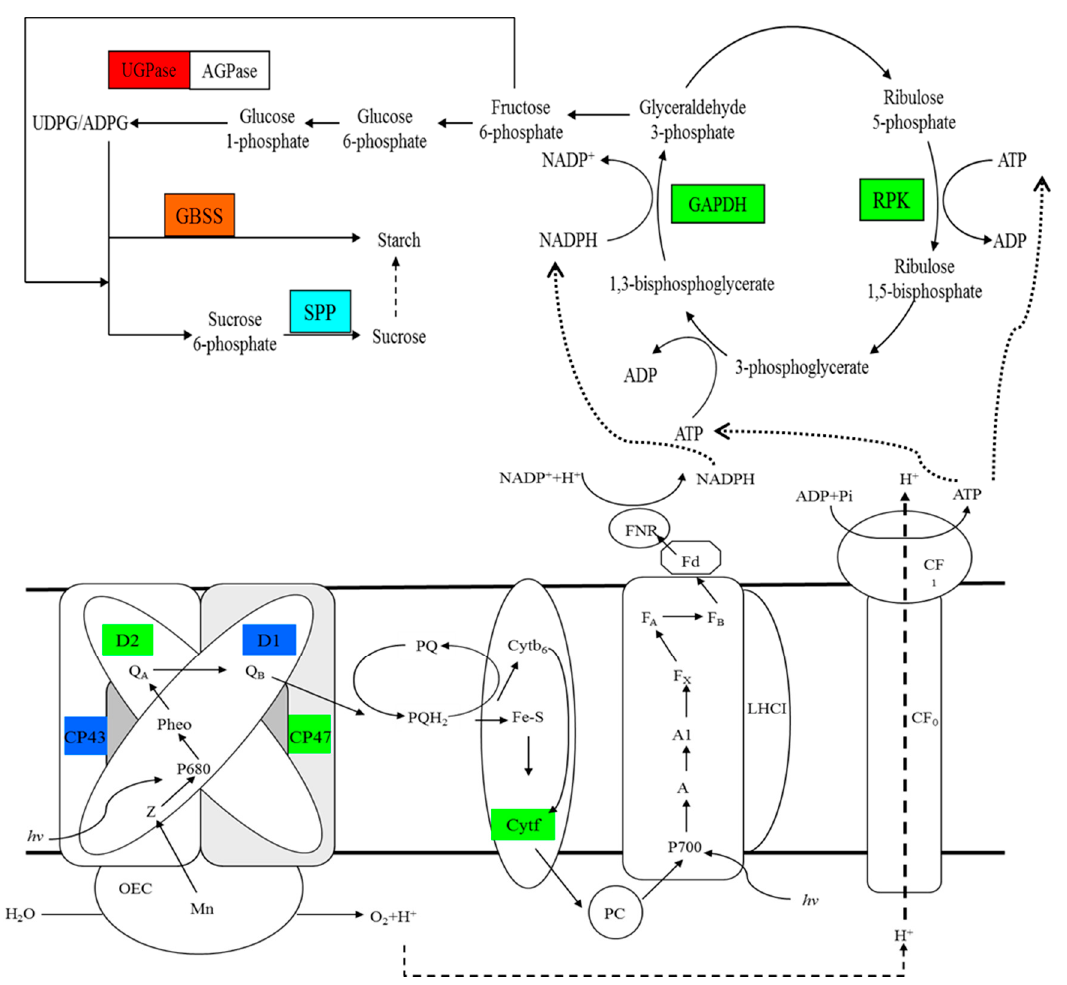
Figure 8. Changes in the photosynthetic electron transfer chain, Calvin cycle, and biosynthesis pathway of sucrose and starch in response to rapid changes in temperature in M. baccata leaves. The red box represents a protein only upregulated at 20 °C as compared to that at 5 °C. Green boxes indicate proteins only downregulated at 0 °C as compared to that at 5 °C. Oxford blue boxes indicate proteins downregulated at both 20 and 0 °C as compared to that at 5 °C. The light blue box indicates a protein only downregulated under calcium treatment at 0 °C. The orange box represents a protein upregulated at both 20 °C as compared to that at 5 °C, and under calcium treatment at 0 °C. AGPase, ADP-glucose pyrophosphorylase; Cytb6, cytochrome b6; Cytf, cytochrome f; FNR, ferrdoxin-NDAP + reductase; GAPDH, glyceraldehyde-3-phosphate dehydrogenase; GBSS, granule-bound starch synthase; LHCI, PSI light-harvesting complex; OEC, oxygen-evolving complex; PC, plastocyanin; Pheo, pheophytin; PQ, plastoquinone; PQH2, plastoquinol; PRK, phosphoribulokinase; and UGPase, UDP-glucose pyrophosphorylase.